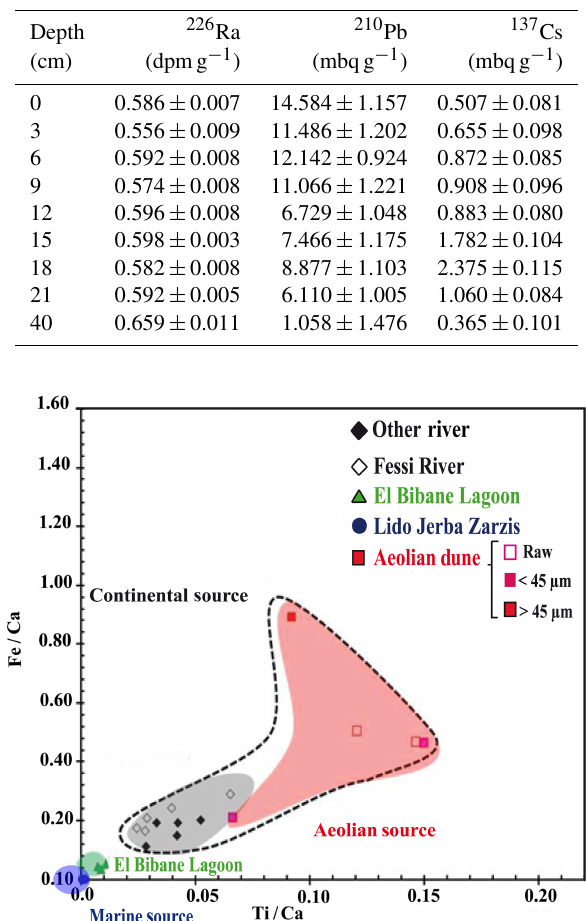
Table 4. Activities of radionuclides 210 Pb, 137 Cs and 226 Ra along core BL12-10.